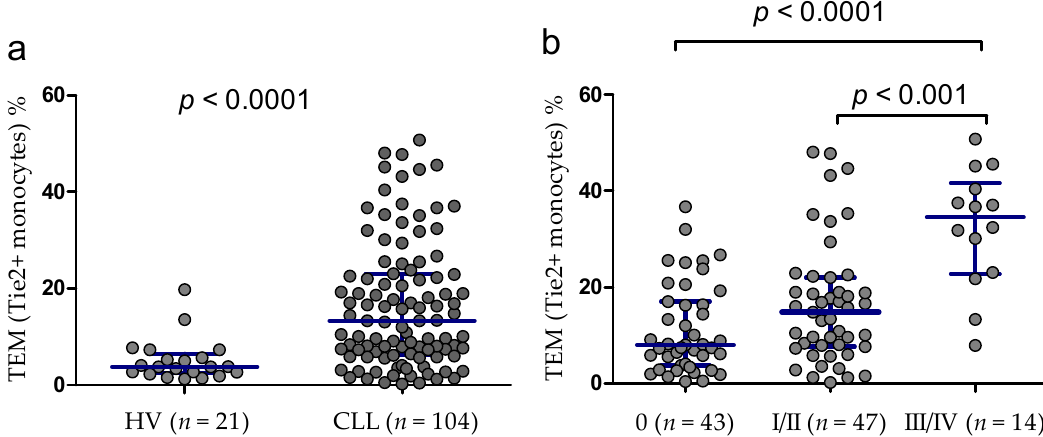
Figure 2. Percentages of Tie2+ monocytes (TEM) in CLL patients and healthy volunteers (HV) ( a ). The percentage of TEMs in peripheral blood of CLL patients at various disease stages (three risk groups) ( b ). Scatter plots present raw data. The central line shows the median. “Whiskers” represent from the first quartile to the third quartile (IQR, interquartile range).